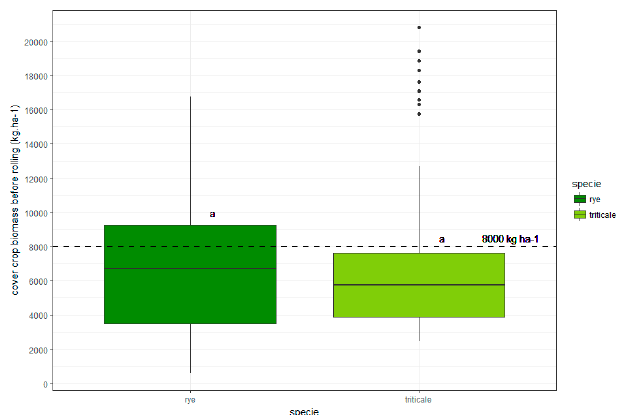
Figure 2. Mean weight of cereal rye and triticale biomass before cover crop rolling, averaged across all sites, 2017 and 2018. The linear mixed model did not indicate significant differences between cereal rye and triticale ( P > 0.05 , n = 144). Data presented in Figure 2 are means ± standard error. Each cover crop species (rye and triticale) followed by the same letter are not significantly different. The dotted line refers to a mean of the cover crop biomass values range reported in the scientific literature as a success factor to suppress weed until soybean harvest.